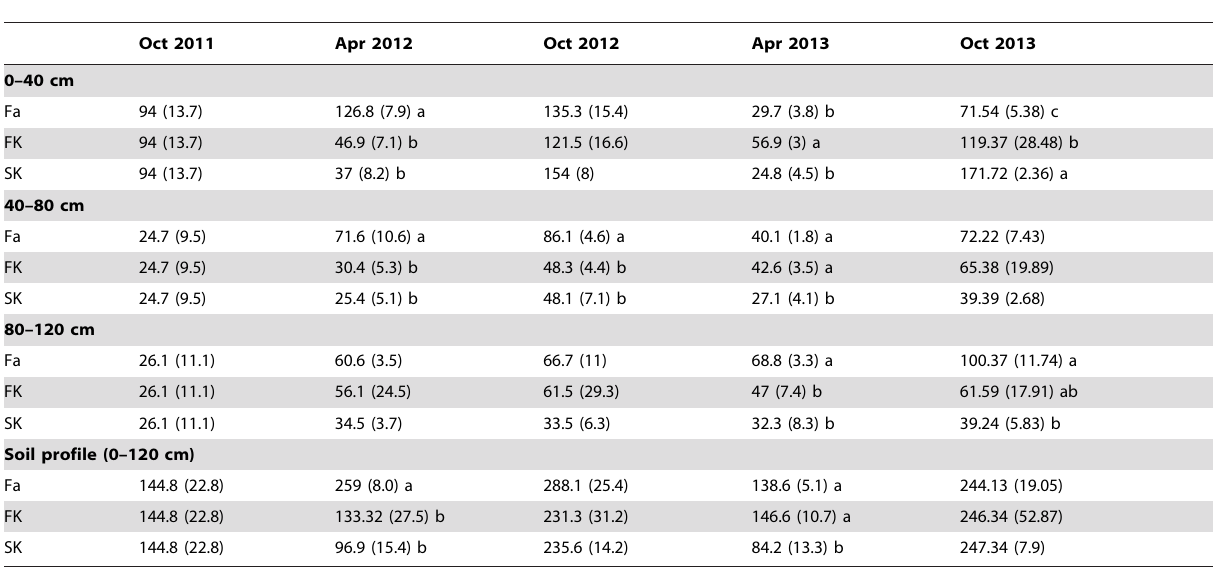
Table 2. Soil inorganic N content (kg N ha 2 1 ) in the different soil layers and the entire profile at different sampling dates for the fallow (Fa), first kill (FK) and second kill (SK) treatments.